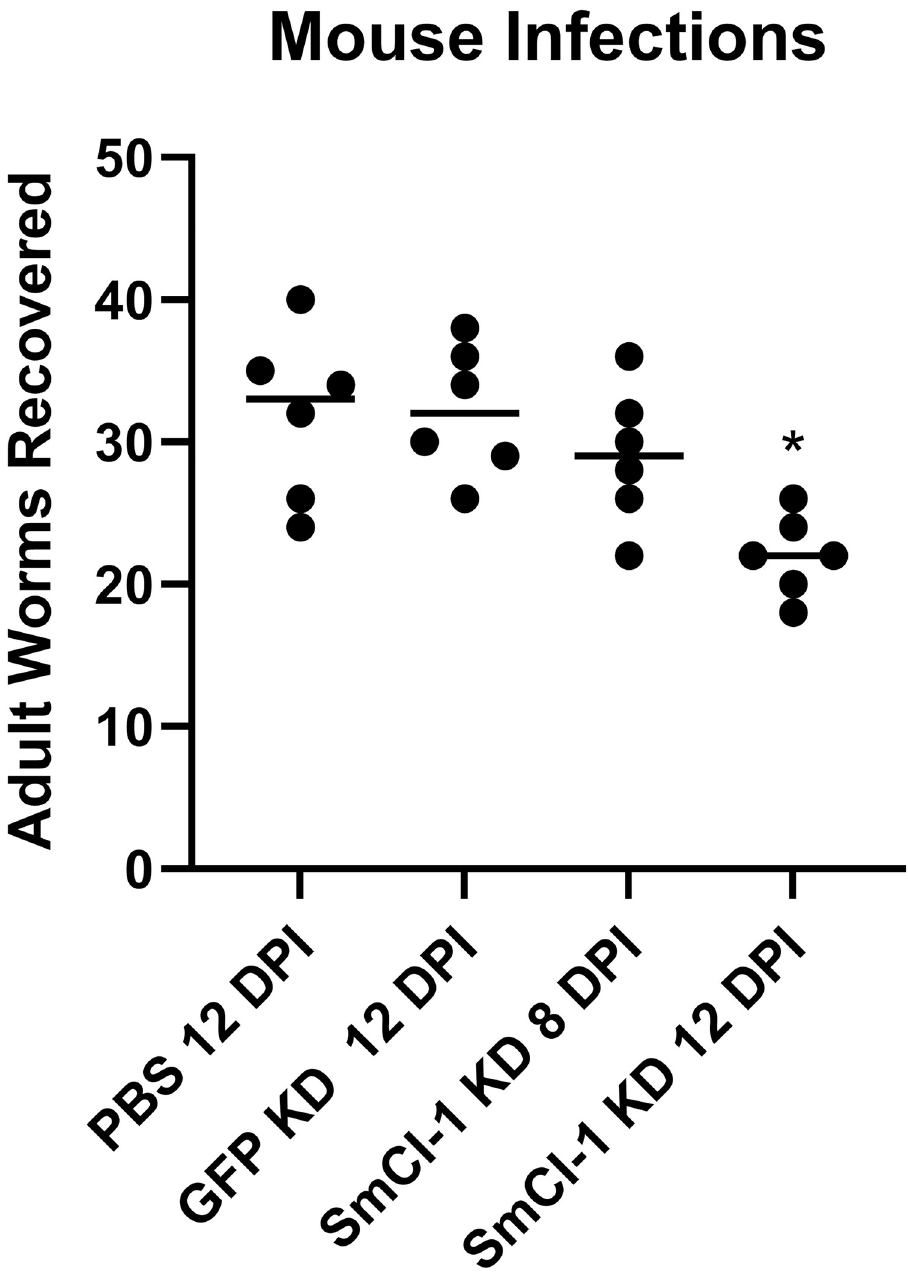
Fig 9. SmCI-1 KD reduces adult worm burden in mouse model. Infection of Swiss Webster mice using 100 S . mansoni cercaria results in different adult worm burdens 5 weeks post infection depending upon cercaria treatment. Cercaria emerged from B . glabrata 12 days post injection with a PBS control, a GFP KD dsRNA construct, a SmCI-1 KD dsRNA construct, or 8 days post injection with a SmCI-1 KD dsRNA construct. ( � ) Indicates a significantly lowered adult worm burden as compared to PBS 12 dpi and GFR KD 12 dpi groups. (n = 6).